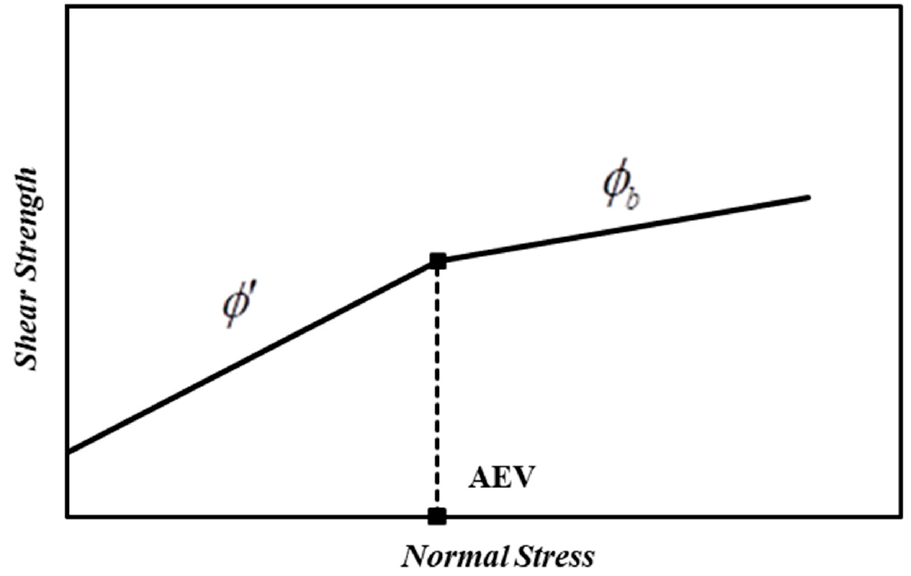
Figure 3. Effect of air entry value on unsaturated shear strength envelopes